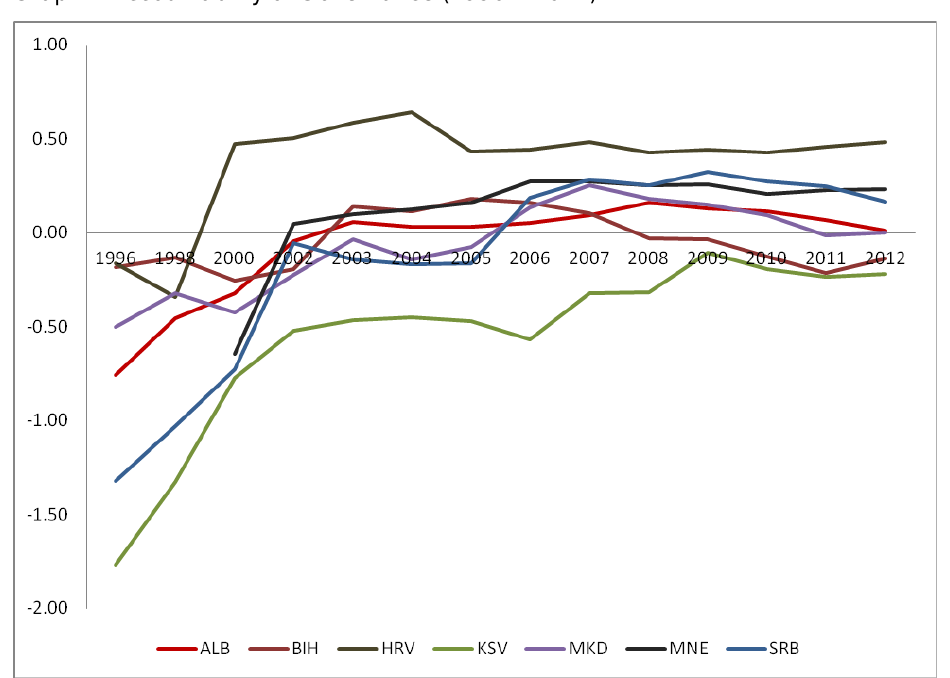
Graph 1.Accountability of Governance (1996 – 2012)